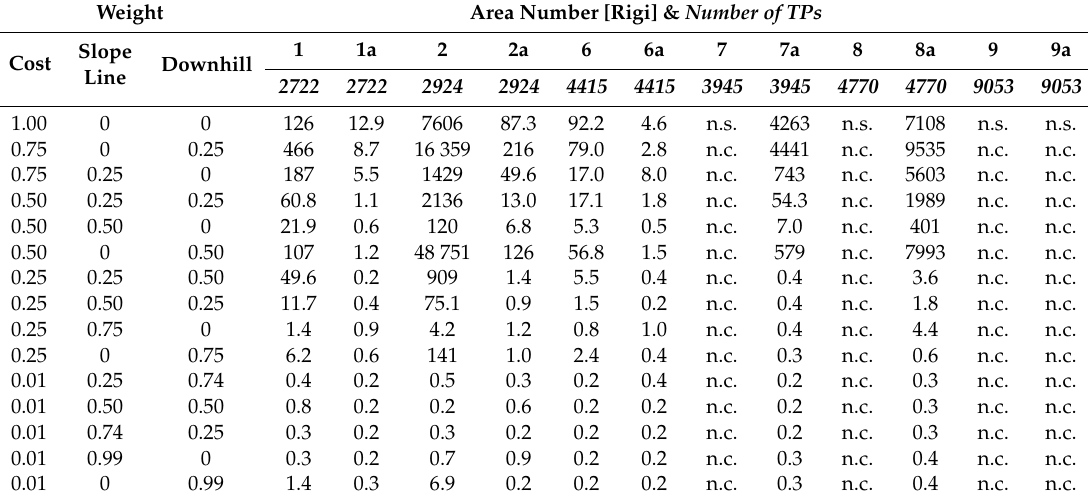
Table 7. Computation time for solving the optimization problem with GUROBI [seconds] (n.s.: not solved within 2 days, n.c.: not calculated). Area numbers with an “a” (e.g. 1a, 2a) indicate that the harvesting volume for helicopter logging is less than for cable logging per parcel ( f H = 1 / 3, basis: f H = 1 / 2).